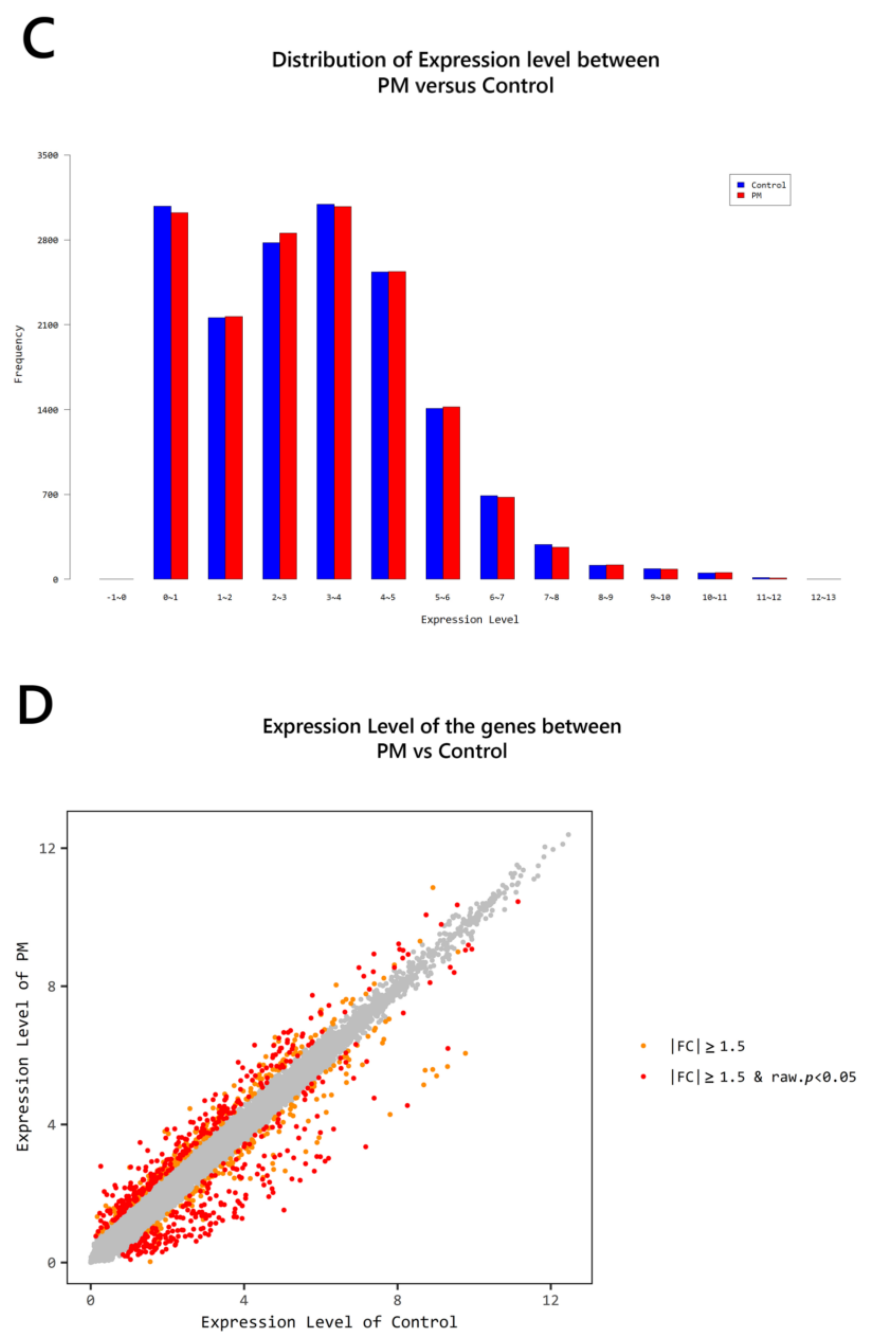
Figure 5. ( A ) Heat map of the one-way hierarchical clustering (PM vs. control). ( B ) Distribution of gene expression level between the PM and the control group. ( C ) Scatter plot of gene expression level. ( D ) Significant gene count by fold change and p -value. n = 4 in each group (PM, control). Only those genes exhibiting log 2 fold change (FC) ≥ 1.5 and p < 0.05 were considered differentially expressed genes.